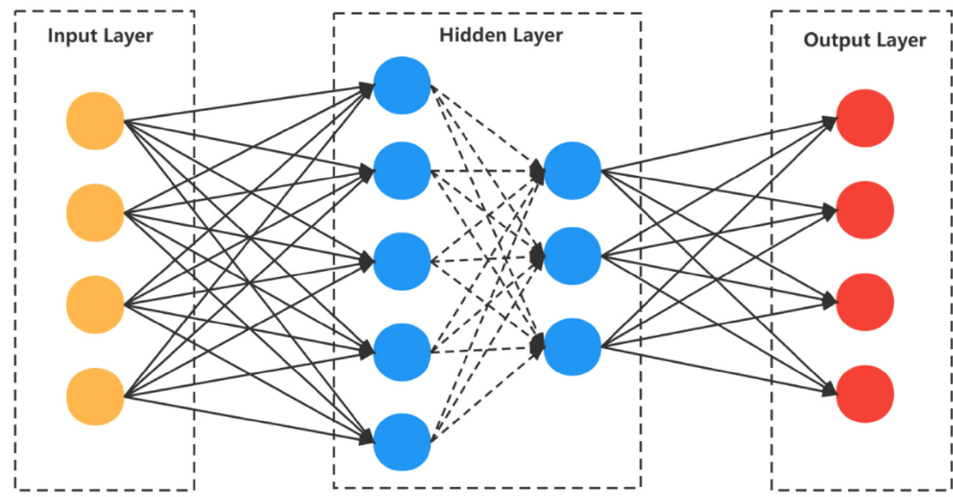
Figure 32. Schematic diagram of deep learning network structure.